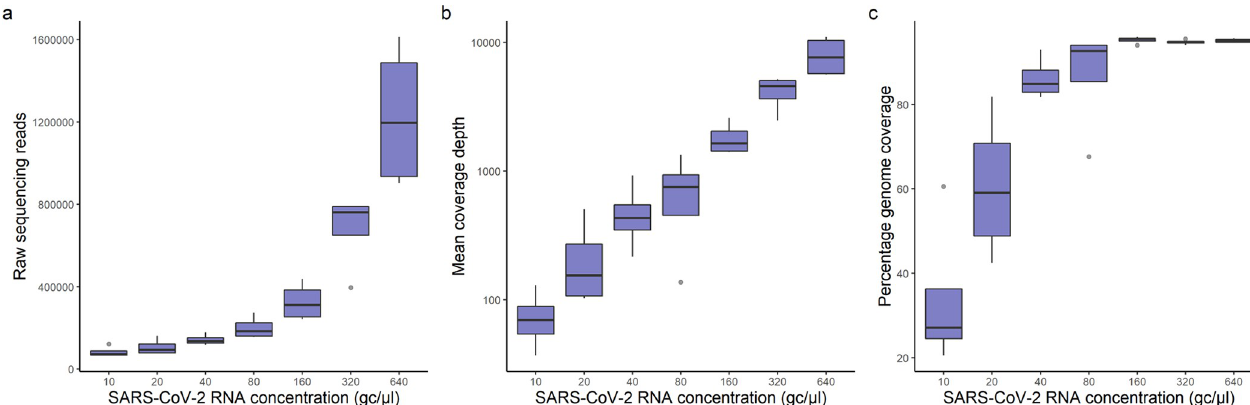
Fig 5. Sequencing metrics from serial dilutions of synthetic SARS-CoV-2 RNA. Boxplots showing total number of raw reads (a), mean coverage depth (b) and percentage coverage breadth (c) obtained at a range of starting RNA concentrations in genome copies/ μ l (gc/ μ l).